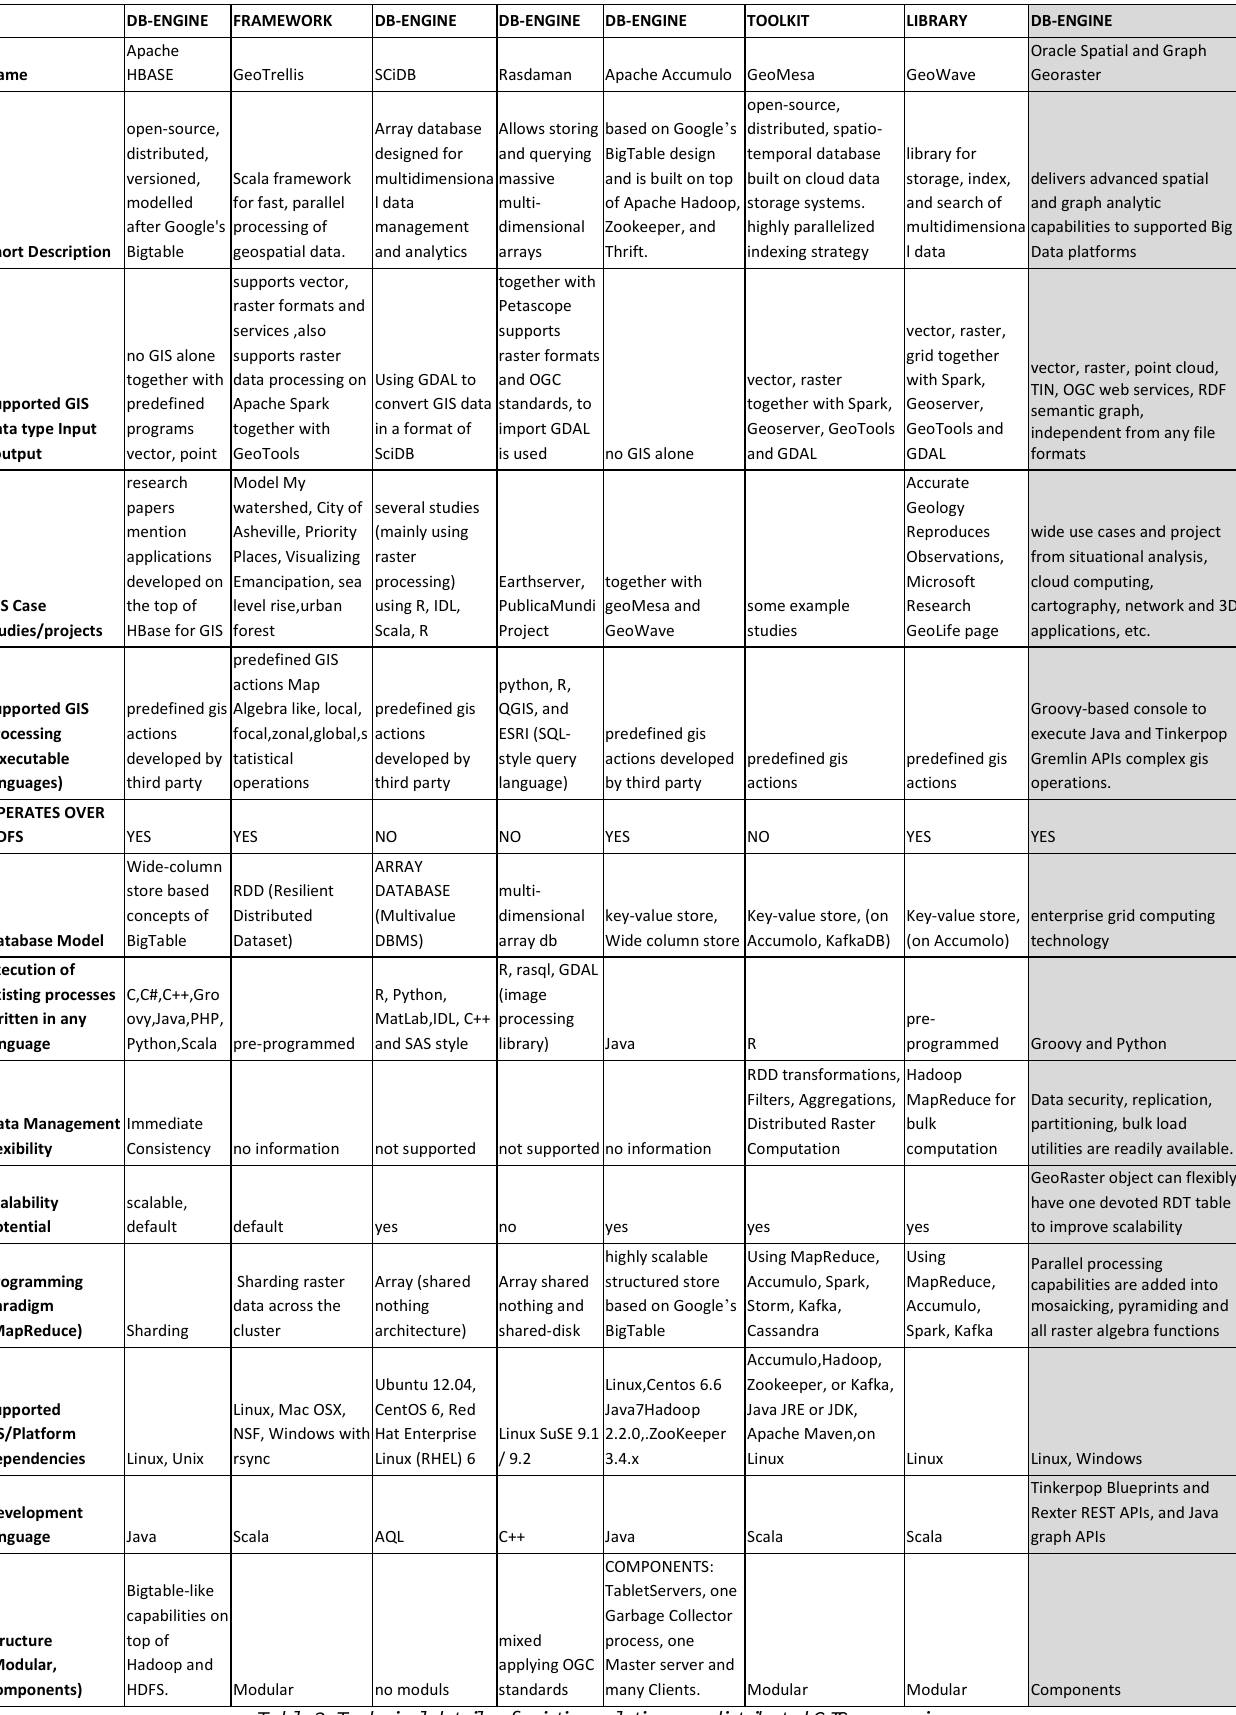
Table 3. Technical details of existing solutions on distributed GIS